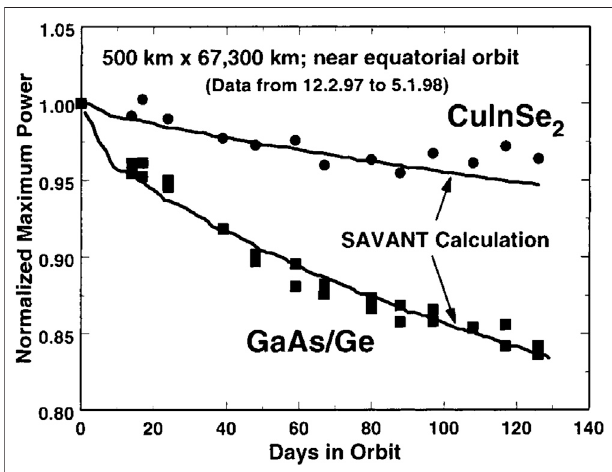
FIGURE 10 | The displacement damage does method measurements for GaAs/Ge and CIS solar cells [88].